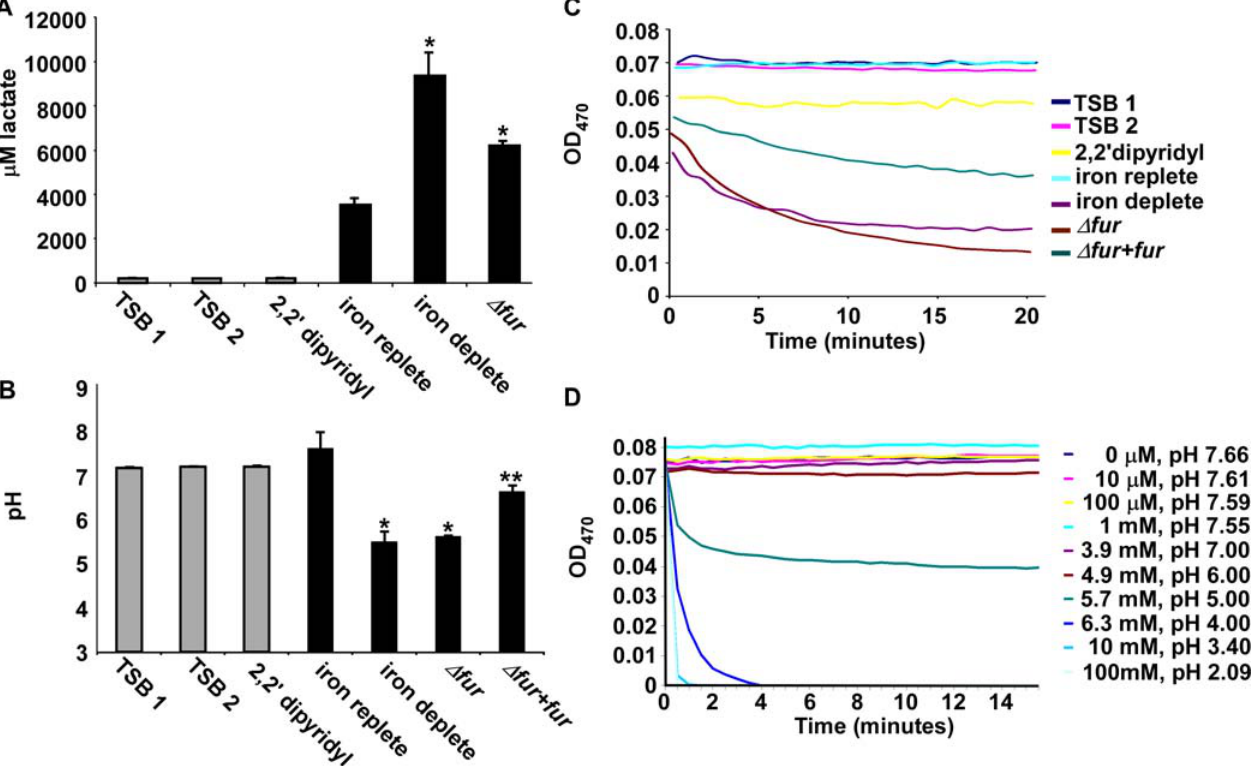
Figure 4. Lactate Produced by Iron-Starved S. aureus Facilitates Iron Release from Transferrin (A and B) pH and lactate concentrations of fresh sterile medium (TSB 1), sterile medium after 15 hour incubation at 37 8 C (TSB 2), fresh sterile medium containing 1mM DIP (2,2 9 dipyridyl), spent medium from wild-type staphylococci grown under iron-replete conditions (iron replete), spent medium from wild-type staphylococci grown under iron-starved conditions (iron deplete), spent medium from the D fur mutant grown in TSB ( D fur), or spent medium from the D fur mutant with full-length fur provided in trans ( D fur þ fur) . Asterisks denote statistical significance as determined by the Student’s t -test. A single asterisk represents a comparison to iron-replete cultures, while dual asterisks represent a comparison to iron-deplete or D fur cultures. (C) Iron release from transferrin mediated by various media samples. A decrease in optical density signifies a release of iron from transferrin. (D) Iron release from transferrin mediated by various lactate concentrations shown as molar values. The corresponding pH of the media containing the listed lactate concentrations is shown. DOI: